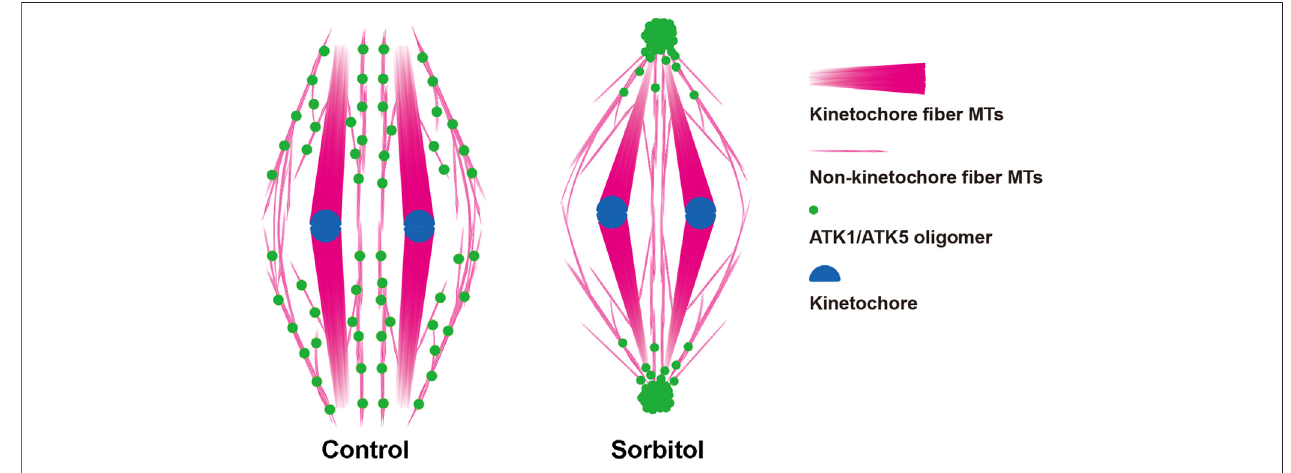
FIGURE 10 | Diagrammatic representation of the redistribution of ATK1/ATK5 oligomers and reorganization of spindle MT arrays after sorbitol treatment.